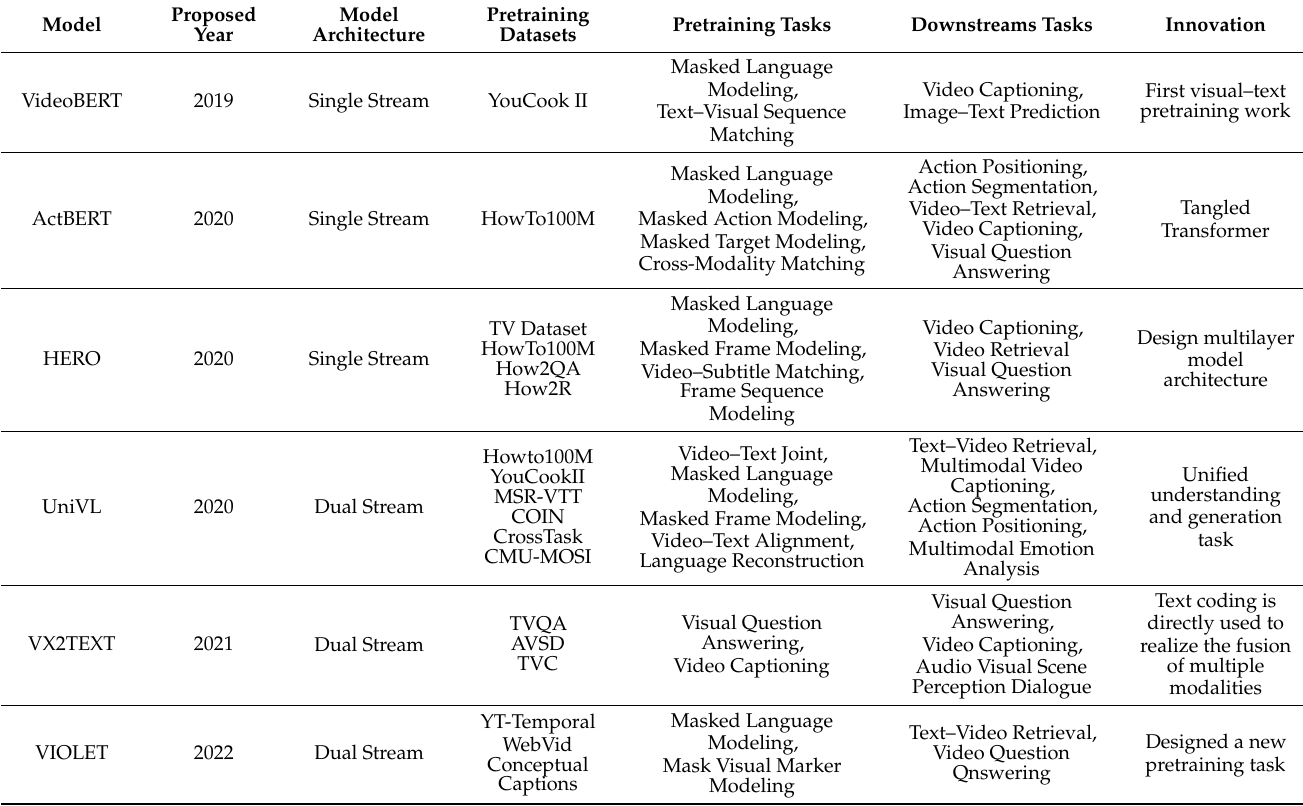
Table 11. Comparison of video–language pretraining